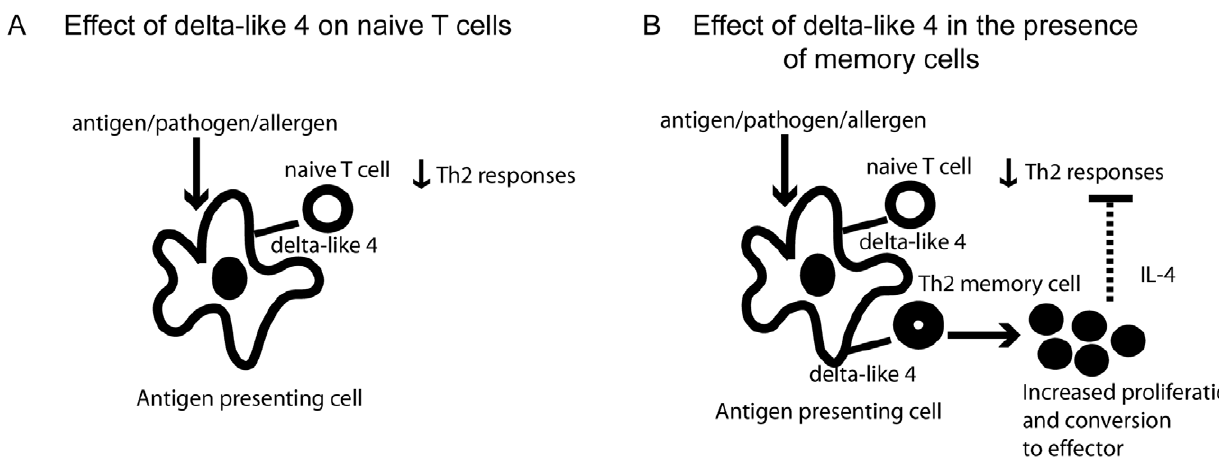
Figure 6. Possible mechanism by which delta-like 4 regulates the T cell immune response.